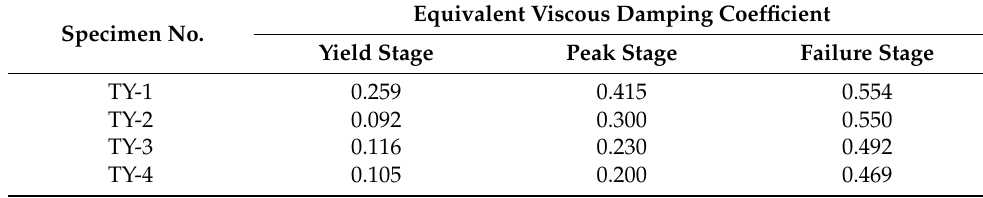
Table 14. Equivalent viscous damping coefficient of TY specimens.